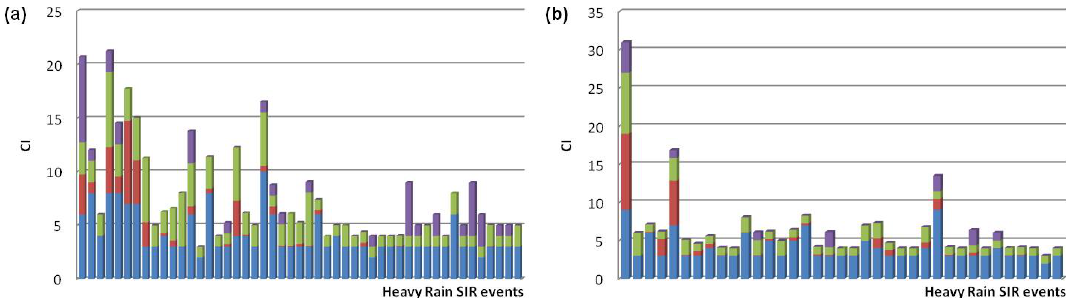
Fig. 8. CI for each SIR event. The factor L R is shown in blue, L P in red, L TR in green and L TW in violet (see text for details), for (a) Catalonia anb (b) the Balearic Islands. Bars arranged from high (left) to low (right) number of requests.